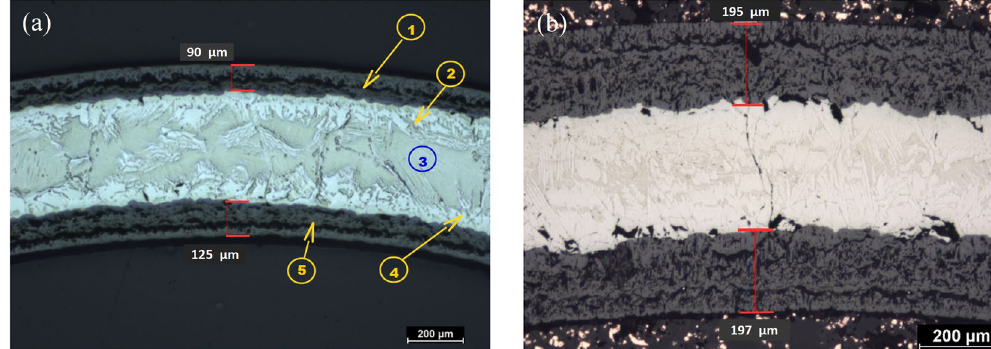
Figure 2. Optical microscopy images of the metallographic cross sections. ( a ) a 300 nm NCD-coated ZIRLO tube sample processed at 1000 °C in hot steam. (1) Outer-surface zirconium dioxide layer, with a thickness of 90.8 μ m. (2) Outer-surface oxygen-stabilized zirconium α phase (solid Zr-O solution). (3) Initial Zr β phase (metastable modified hexagonal close-packed structure). (4) Inner-surface oxygen-stabilized Zr α phase. (5) Inner-surface ZrO 2 layer, with a thickness of 125.02 μ m. ( b ) an uncoated ZIRLO tube sample subjected to hot steam (1000 °C/1 h). On the outer surface of the tube, the ZrO 2 thickness was 195.13 μ m; on the inner surface, the ZrO 2 thickness was 196.8 μ